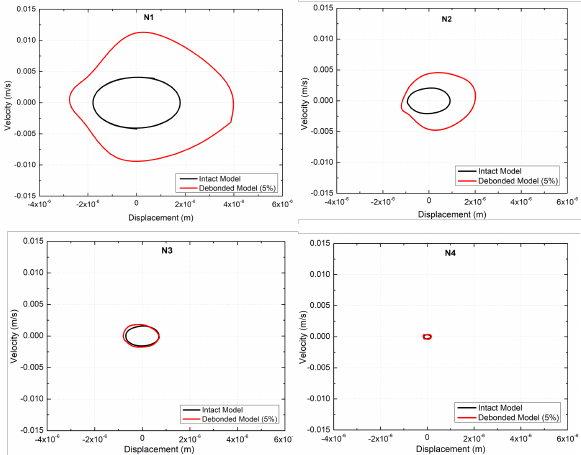
Figure 9: Comparison of phase portrait calculated at different mea- surement points at frequency ratio η